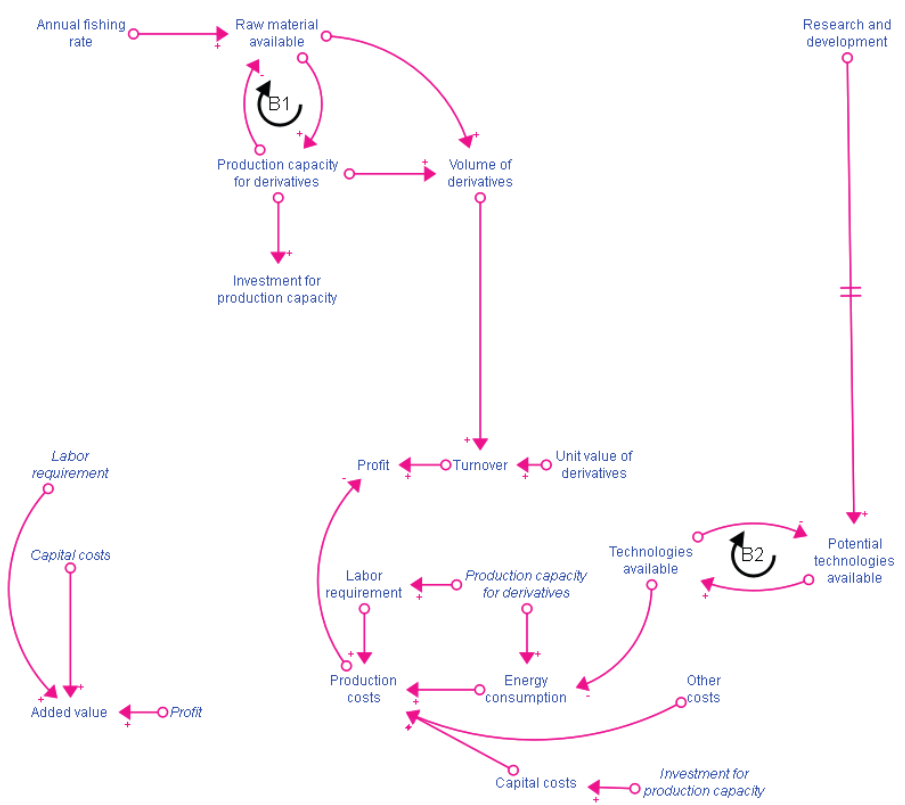
Fig. 6. Fishing causal loop